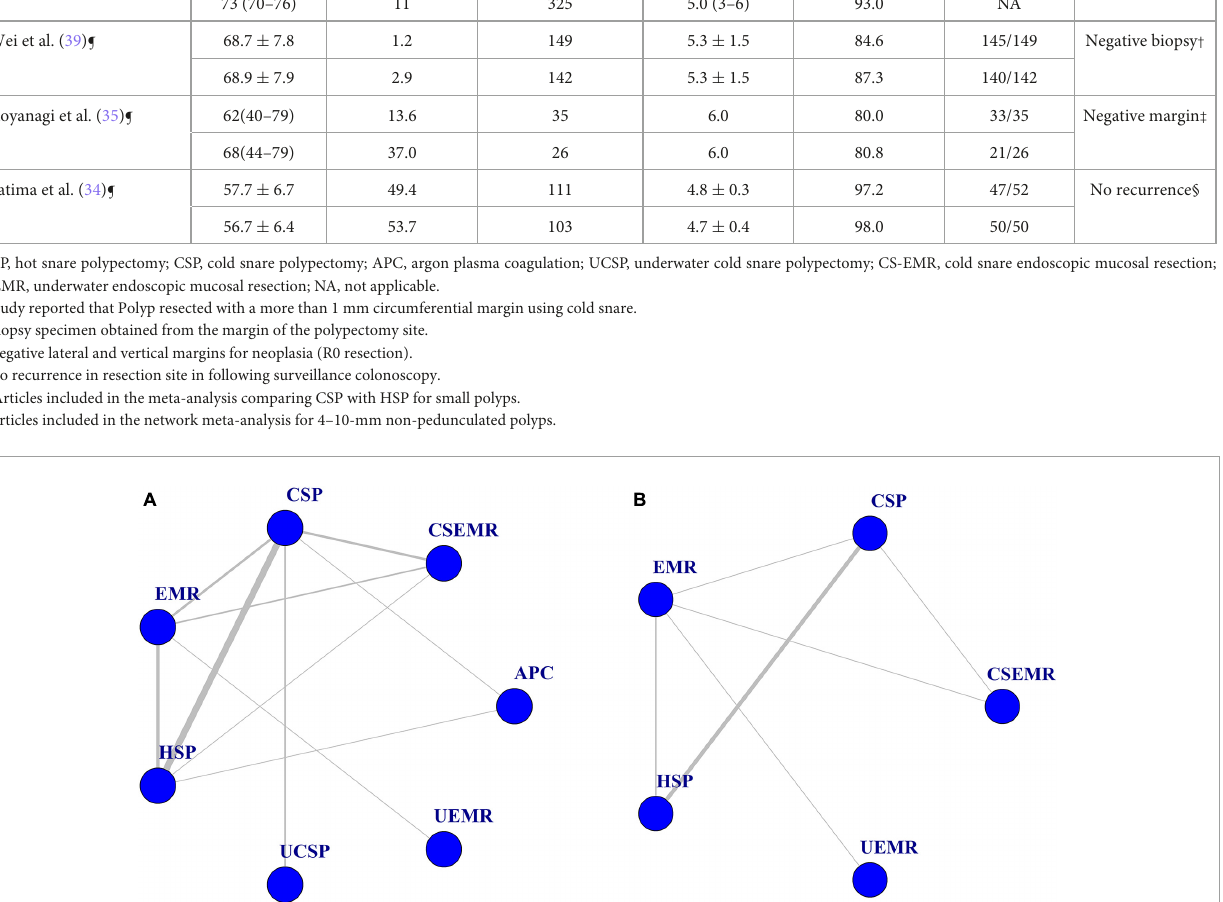
For major PPB and PPB, 14 articles compared seven treatments (3,316 patients) (27, 29, 30, 32–37, 39, 40,